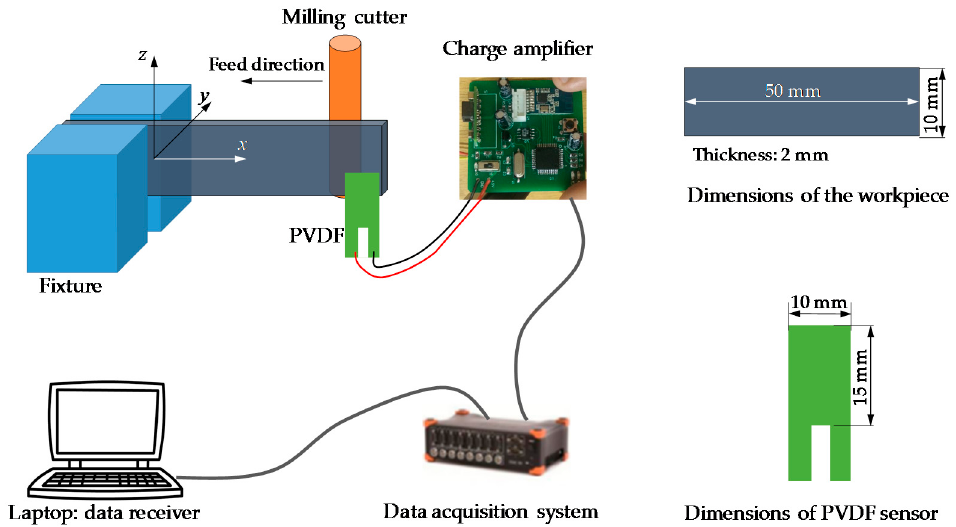
Figure 3. Flow of the real-time monitoring of workpiece deflection.